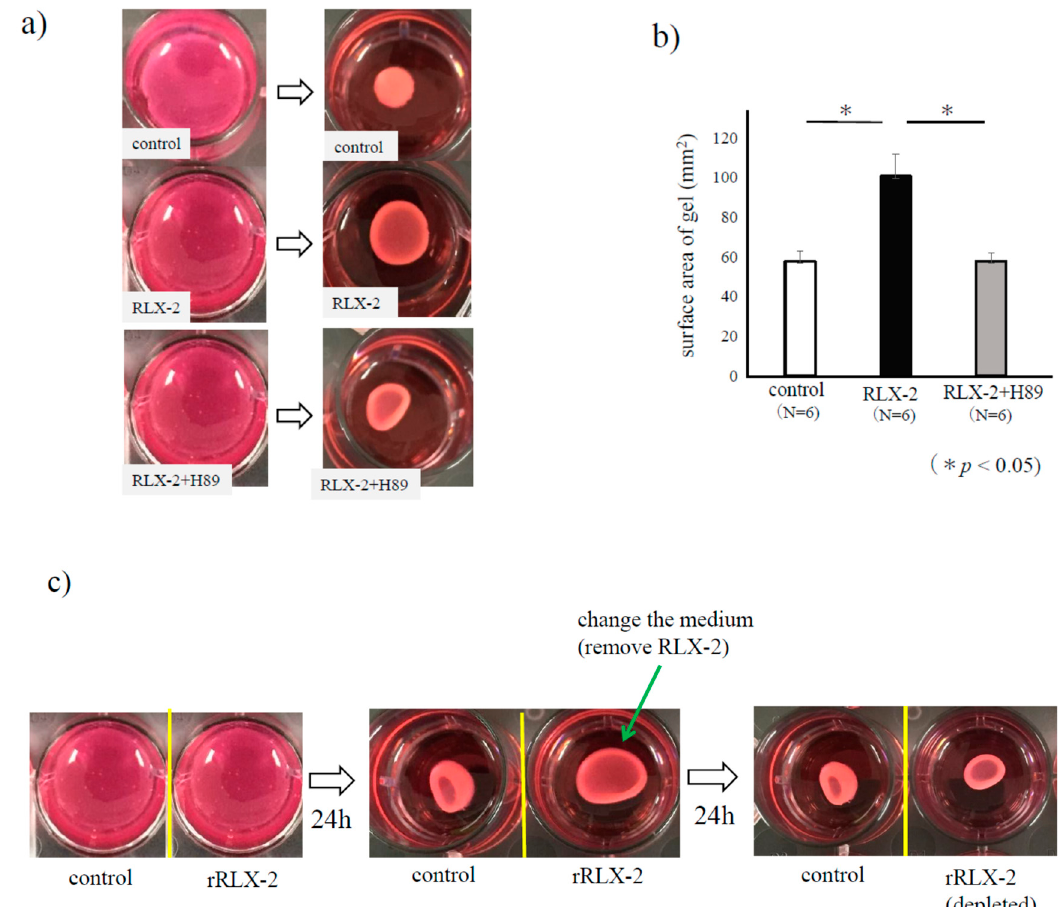
Figure 3. The relaxin (RLX)-2 effect on collagen gel contractility of endometriotic stromal cells (ESCs). Collagen gel contraction assay was performed to evaluate the effect of RLX-2 on the contractility of ESCs in the presence of 10% FBS. After 24 h-s RLX-2 stimulation for ESCs, gel areas were approximated by multiplying the major axis diameter by the minor axis diameter in the control and RLX-2 group. In some experiments, ESCs were treated with 5 µM of H89, an inhibitor of Protein Kinase-A, for 1 hr, followed by the treatment of RLX-2 (100 ng/mL) for 24 h ( a ). Data from three different experiments were shown as the mean ± SEM relative *: p < 0.05 ( b ). To check the viability of ESCs after RLX-2 stimulation of 24 h, RLX-2 was removed from medium, and ESCs were cultured with control medium for another 24 h ( c ).